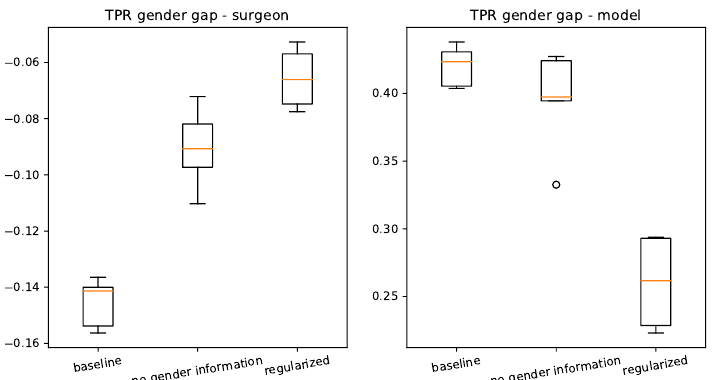
Figure 5. Box plots of the True Positive Rate (TPR) gender gaps for the output classes Surgeon and Model obtained using the baseline models with raw biographies, the baseline models with unbiased biographies, and the regularised models with raw biographies. Note that there is a bias in favour of females or males if a TPR gender gap is positive or negative,